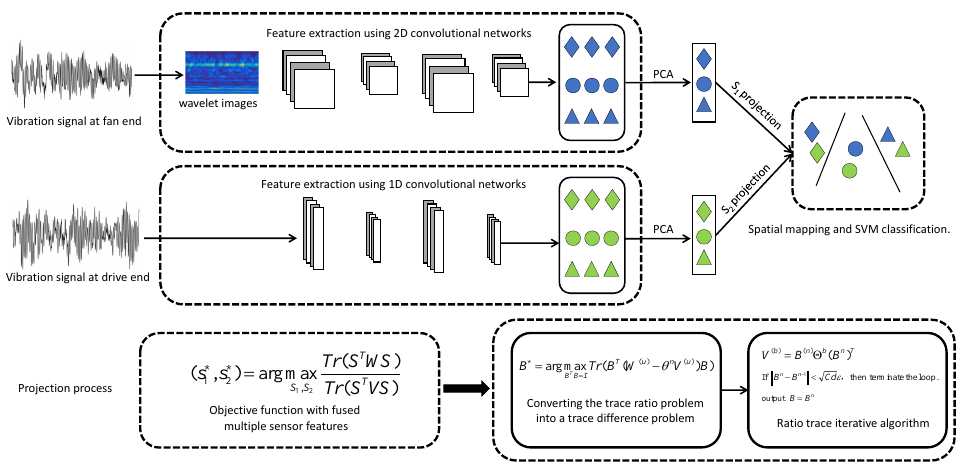
Figure 4. The framework of our proposed